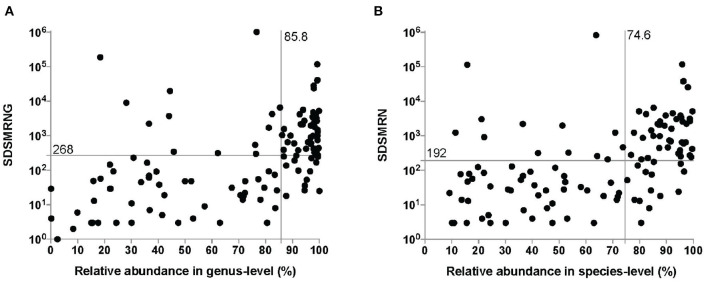
The number of unique reads and relative abundance of identified pathogens by the metagenomic next-generation sequencing (mNGS) approach at the genus level (A) and species level (B). The median number of unique reads and the relative abundance at the genus level were 268 and 85.8%, respectively. The median number of unique reads and the relative abundance at the genus level were 192 and 74.6%, respectively. SDSMRNG, standardized number of reads stringently mapped to pathogen in genus level; SDSMRN, standardized number of reads stringently mapped to pathogen in species level.